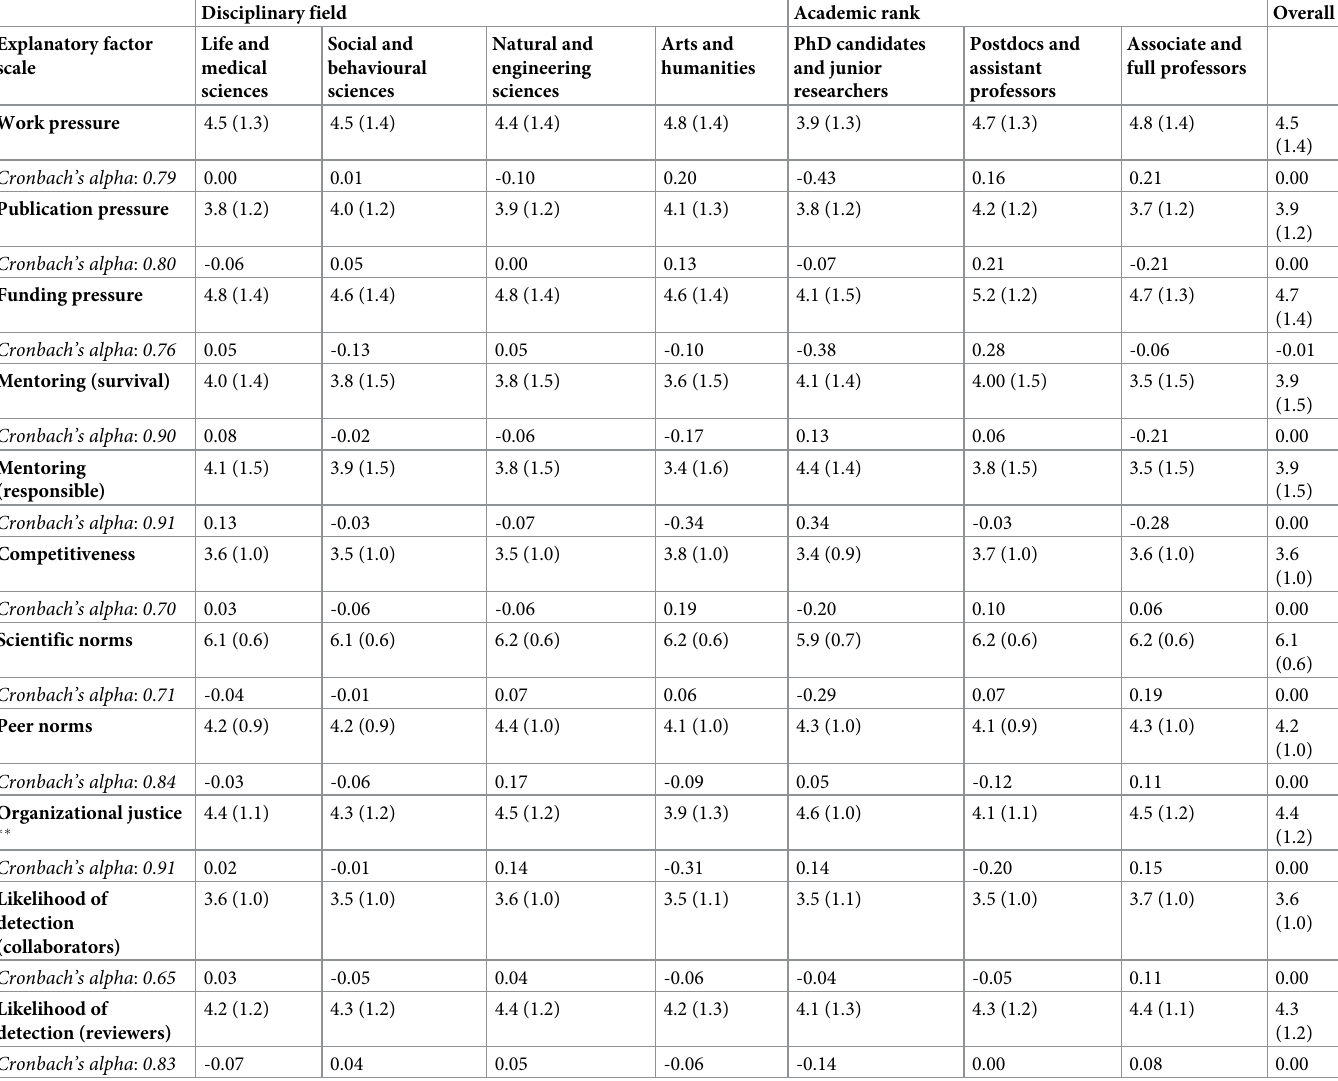
Table 1. Mean scores (standard deviations) and z scores of explanatory factor scales stratified by disciplinary field and academic